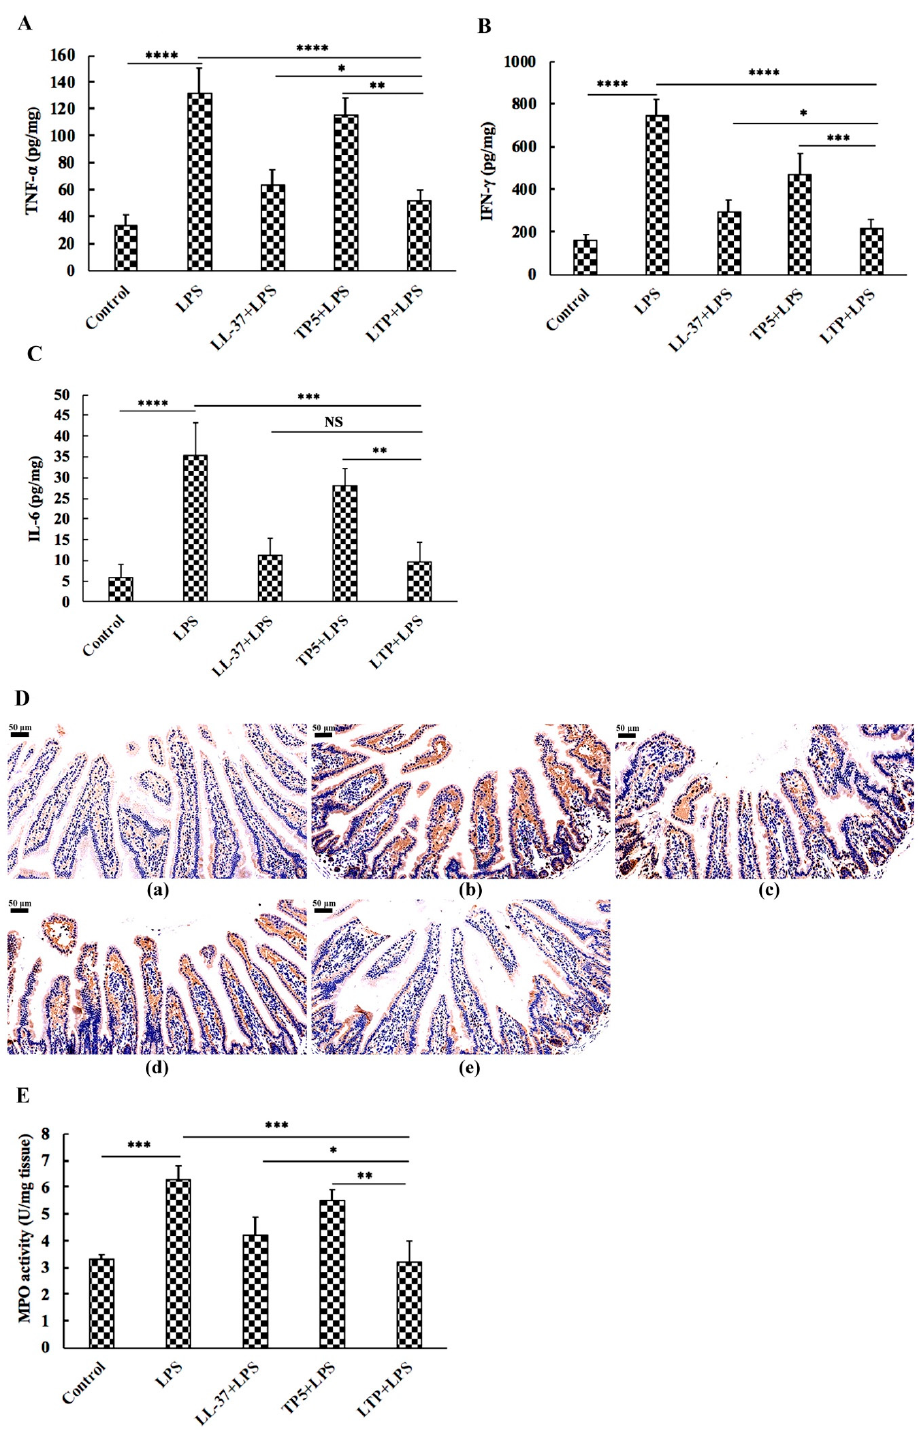
Figure 5. The protective e ff ects of LTP on the inflammatory response. After treatment with 10 mg / kg LPS in the presence or absence of peptides, protein levels of TNF- α ( A ), IFN- γ ( B ), and IL-6 ( C ) in mouse jejunum tissue were quantified by ELISA. ( D ) Representative images of CD177 + . Bar, 50 µ m. ( D - a ) control, ( D - b ) LPS, ( D - c ) LL-37 + LPS, ( D - d ) TP5 + LPS, and ( D - e ) LTP + LPS. ( E ) Enzymatic activities of MPO. Data are presented as the mean value ± standard error from 12 biological replicates. NS: p > 0.05, *: p ≤ 0.05, **: p ≤ 0.01, ***: p ≤ 0.001, ****: p ≤